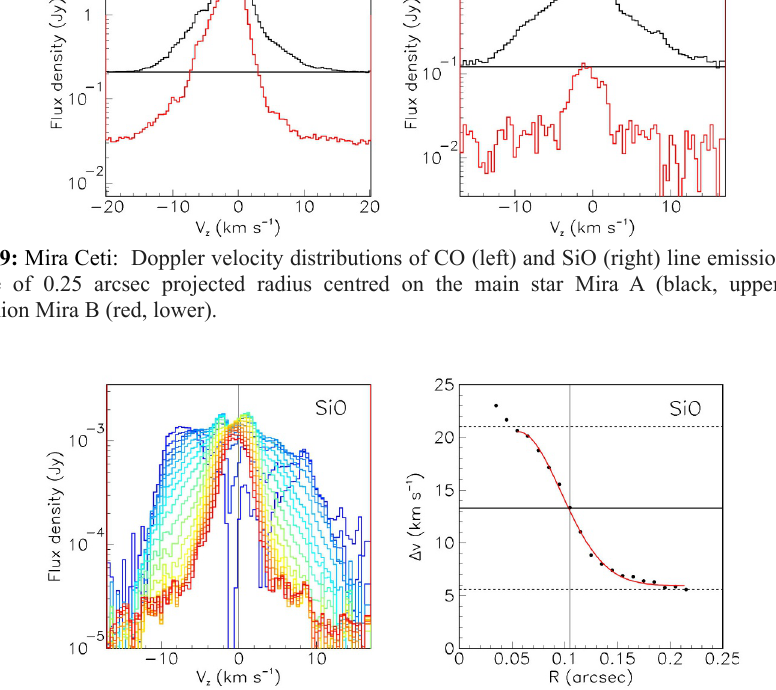
Figure 10: Mira Ceti: Left: Doppler velocity spectra of SiO averaged in 0.03 arcsec wide rings centred on Mira A with mean radii increasing from 0.025 arcsec (blue) to 0.215 arcsec (red) in steps of 0.01 arcsec. Right: dependence on R of the full-with at 1/5 maximum of the spectra displayed in the centre-right